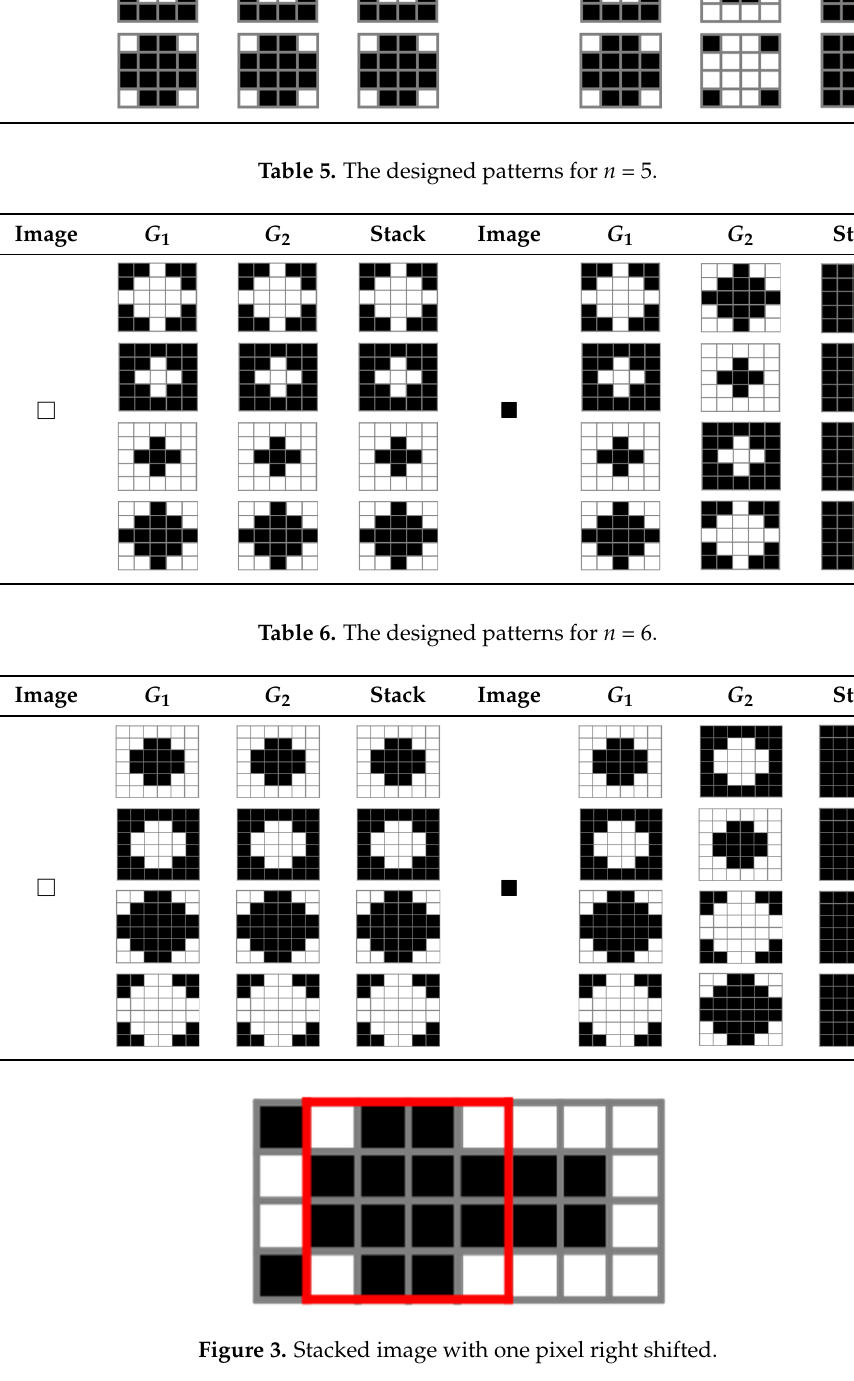
Figure 3. Stacked image with one pixel right shifted.